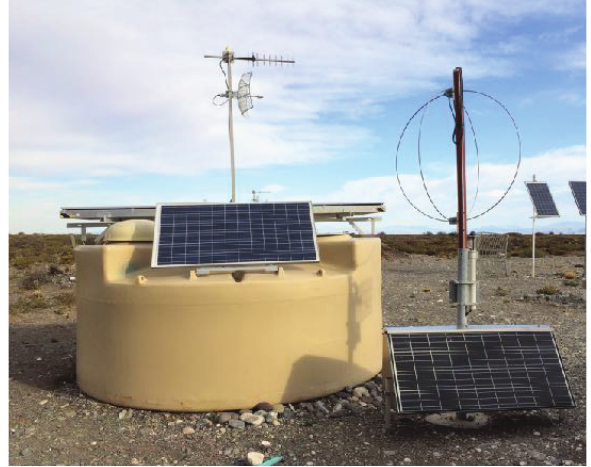
Figure 12. A prototype Radio Detector station (front, right). The SALLA antenna is visible with its two antenna rings with a diam- eter of 1.2 m. On the left a Surface Detector station of the Pierre Auger Observatory with a Surface Scintillator Detector module on top of a water-Cherenkov detector.